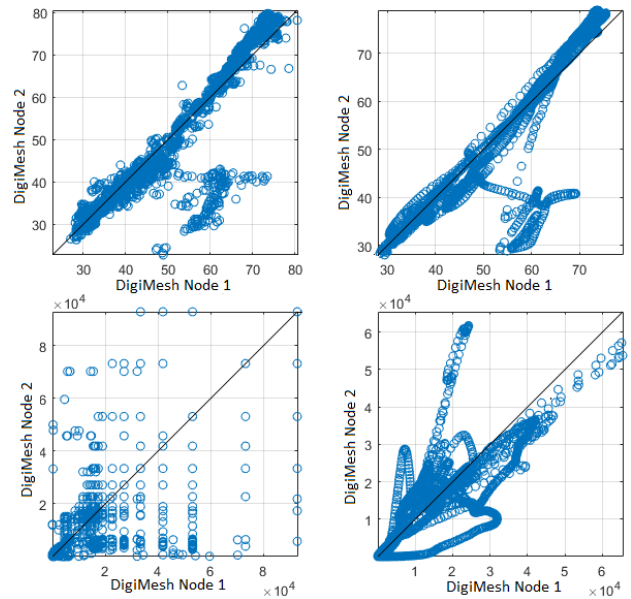
Figure 16. Scatterplots between two sensor nodes in the DigiMesh network: ( top ) air relative humidity, showing that the moderate noise does not mask the existence of two kinds of states, one for similar measurements, and another for different inter-node measurements; ( bottom ) luminosity; ( left ) not filtered; and ( right ) filtered, showing, in this case, the strong structuring effect of filtering on both signals, and the differences in their measurements, which are not evident in the unfiltered